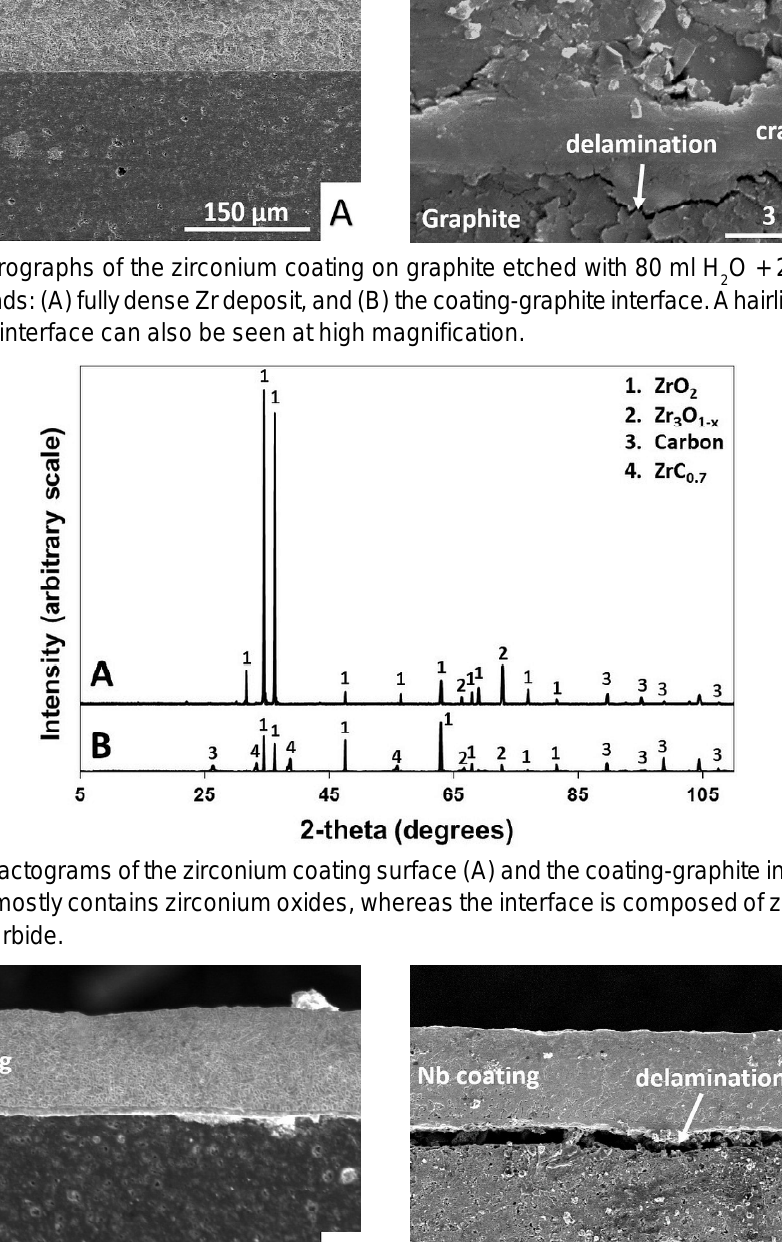
Fig. 6 . SEM micrograph of the niobium coating on graphite etched with 50 ml HNO H O for 15 seconds. The coating is fully dense and crack free (A), and delaminated in some locations during 2 SEM sample preparation (B). The coating fully detached as a single solid sheet during sample preparation for interface XRD